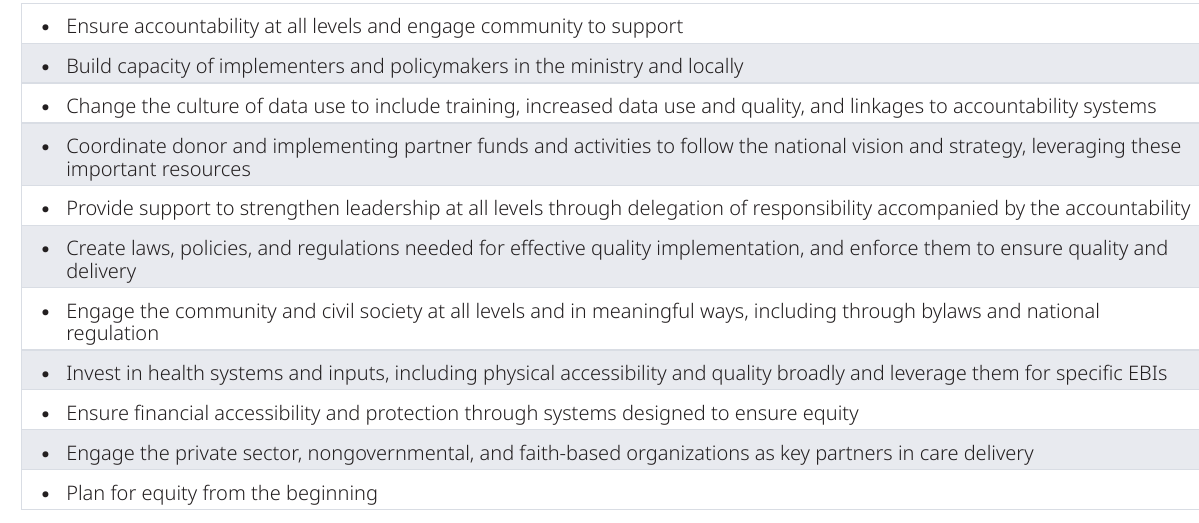
Table 5. Transferable Lessons for Countries Looking to Accelerate Decline in Under-5 Mortality Through More Effective Evidence-Based Intervention